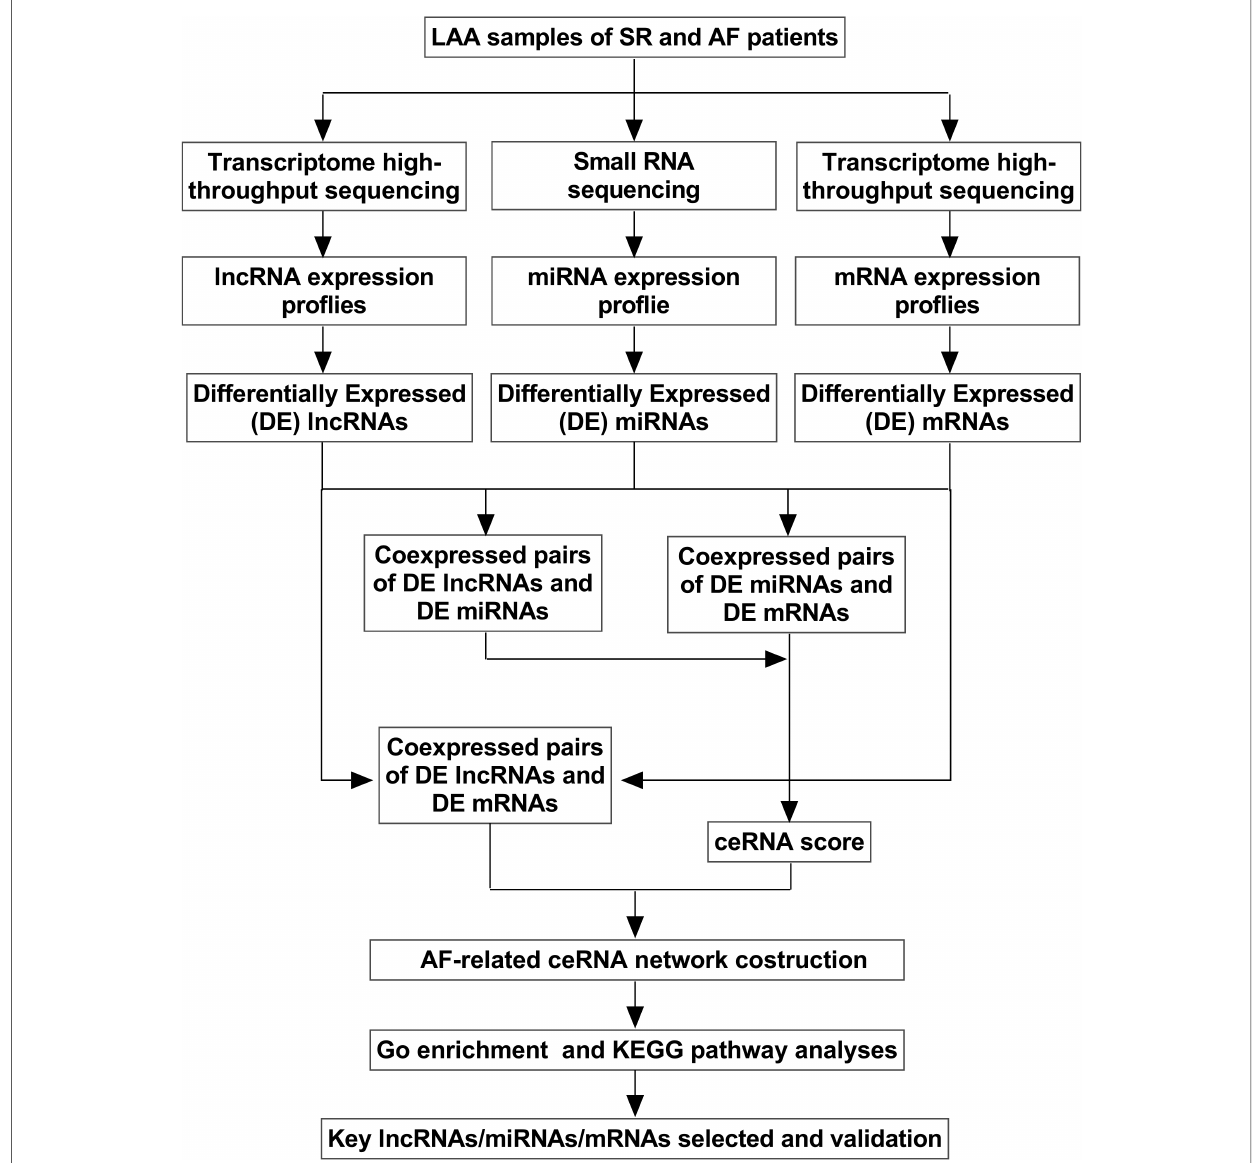
FIGURE 1 Flow chart of biological information analysis. LAA, left atrial appendage tissue; SR, sinus rhythm; AF, atrial fi brillation; GO, Gene Ontology; KEGG, Kyoto Encyclopedia of Genes and